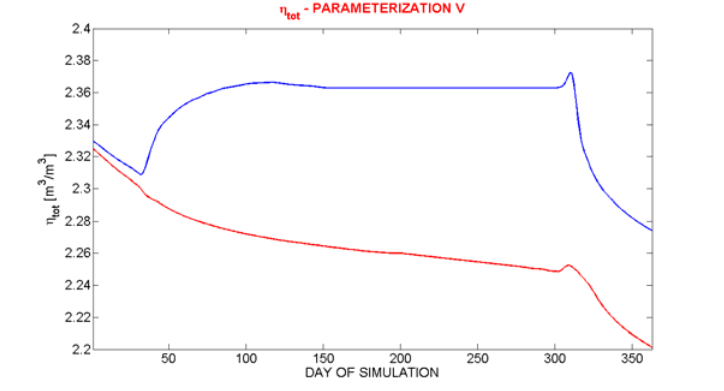
Figure 15. Same as Figure 14 but for the parameterization V.